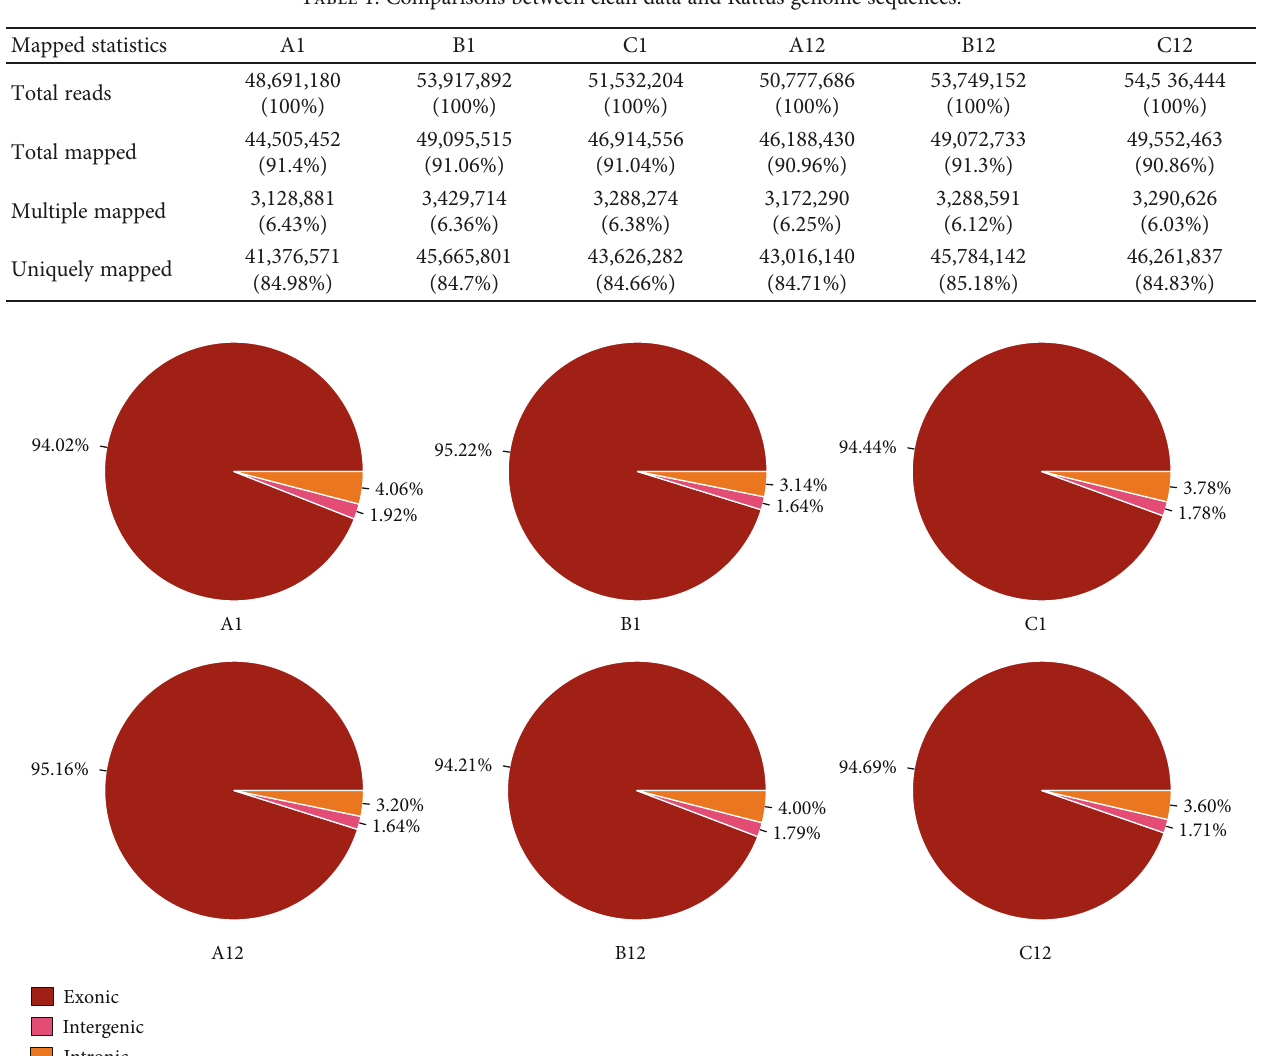
Figure 2: Mapped read distribution of each